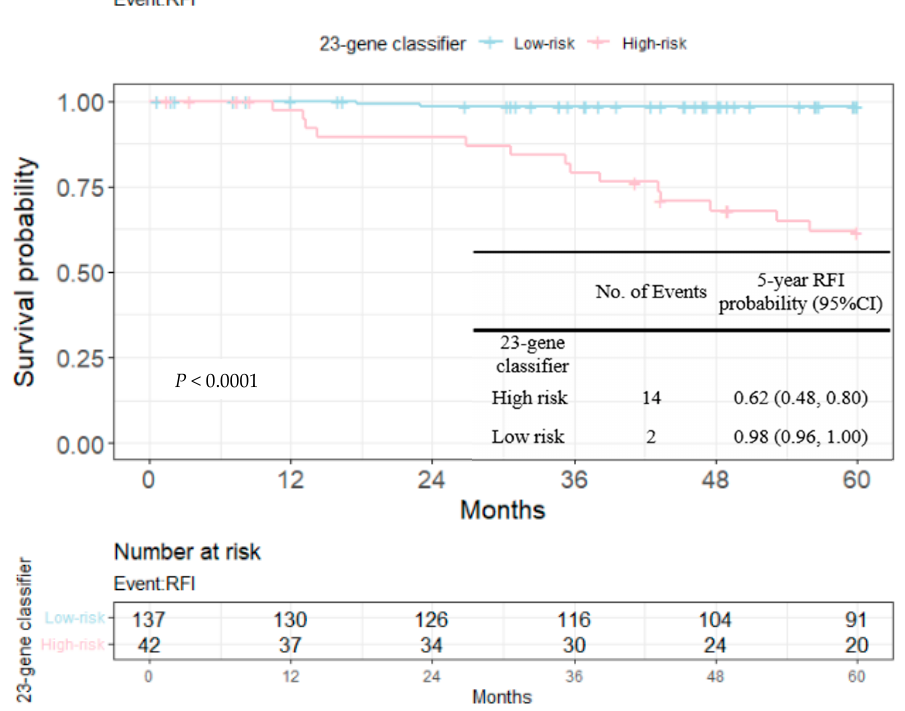
Figure 5. Kaplan–Meier plot for RFI within 5 years in clinically high-risk group to compare the partition of 23-gene classifier. Blue: genetic low-risk group; red: genetic high-risk group.